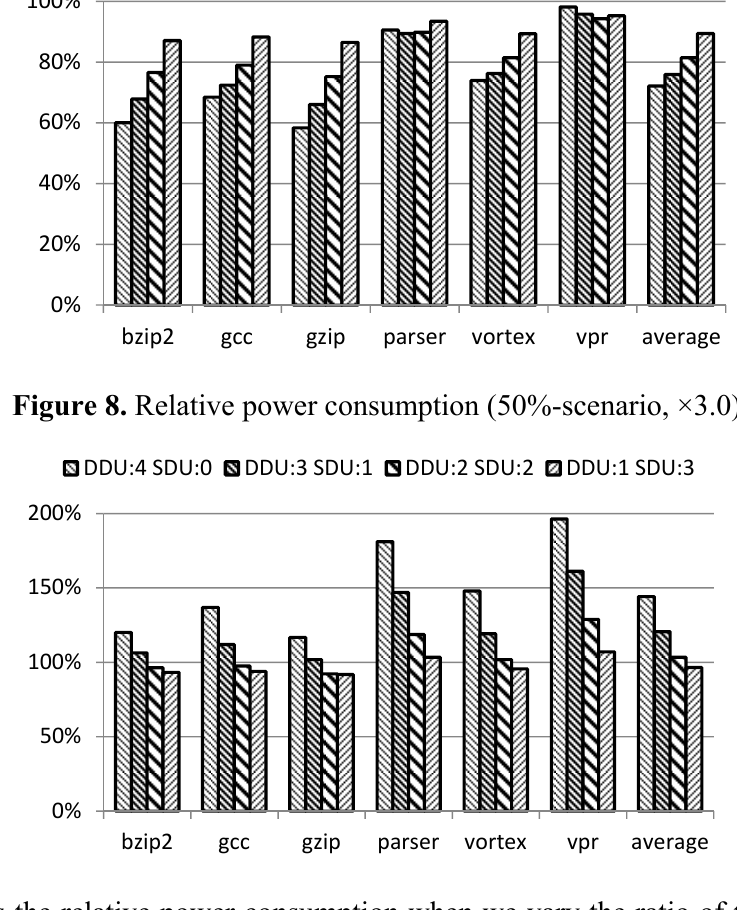
Figure 7. Relative power consumption (50%-scenario, ×1.5).